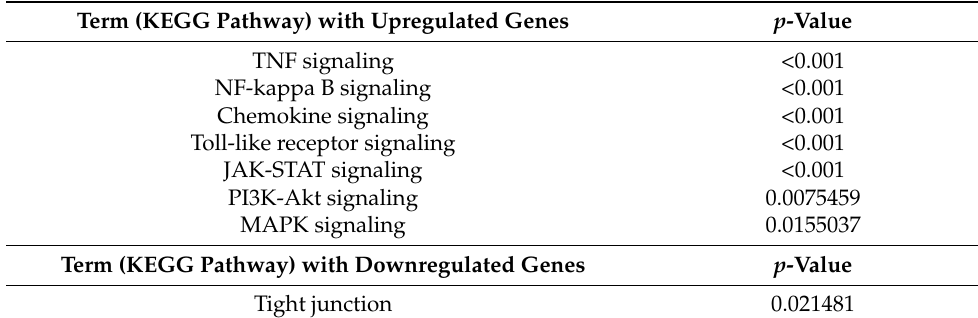
Table 3. Enrichment analysis of transcriptomic data after LPS (NC/PBS vs. NC/LPS). KEGG pathway: NC/PBS vs. NC/LPS.